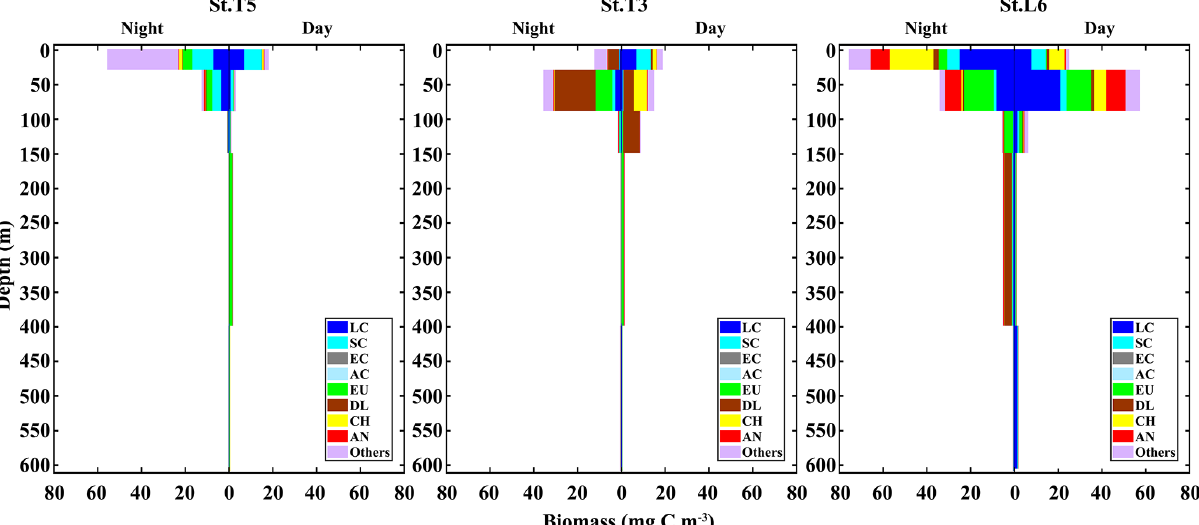
Figure 4. Daytime vs. nighttime vertical distribution of biomass of dominant taxonomic groups at three stations off northern Chile: off Iquique (Stations T5 and T3) and off Coquimbo (Station L6). Data are from night and day replicated samples during 2 consecutive days in the austral spring 2015. Values represent means from sampling size n = 4 for Sts. T5 and T3, and n = 2 for St. L6.